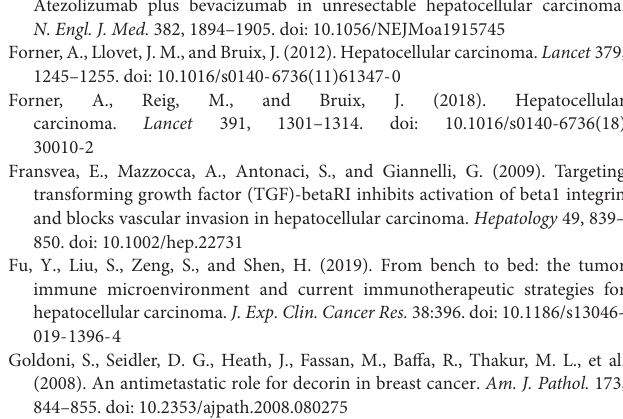
Supplementary Figure 1 | Quantification analysis of DCN expression in normal tissues, tumor tissues and PVTT tissues at protein level. Supplementary Figure 2 | Explore the downstream targets of DCN involved in inhibiting HCC metastasis. Supplementary Figure 3 | Quantification of the WB membranes in Figure 5A . Supplementary Figure 4 | Explore ECM components that could be involved in inhibition of HCC metastasis through DCN upregulation. Supplementary Figure 5 | Expression levels of integrin β 1 in clinical matched samples. Supplementary Figure 6 | Quantification of the WB membranes in Figure 7E